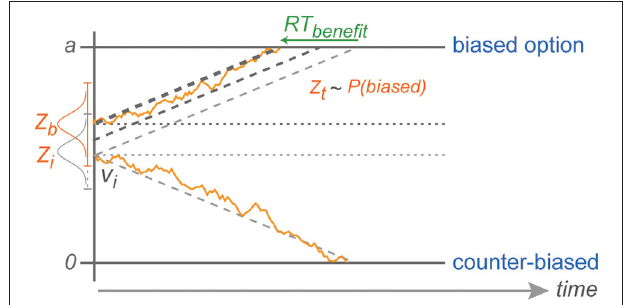
FIGURE 8 | Explanation of counter-biased choice. Z depicts the range in which the stochastic baseline shift operates. Counter-biased choice is possible only when the baseline shift in a given trial is still close to the initial baseline (lightest gray horizontal dotted line in the middle). This explains the pattern of choice RTs against the bias that are similar to choice RTs in the zero-bias